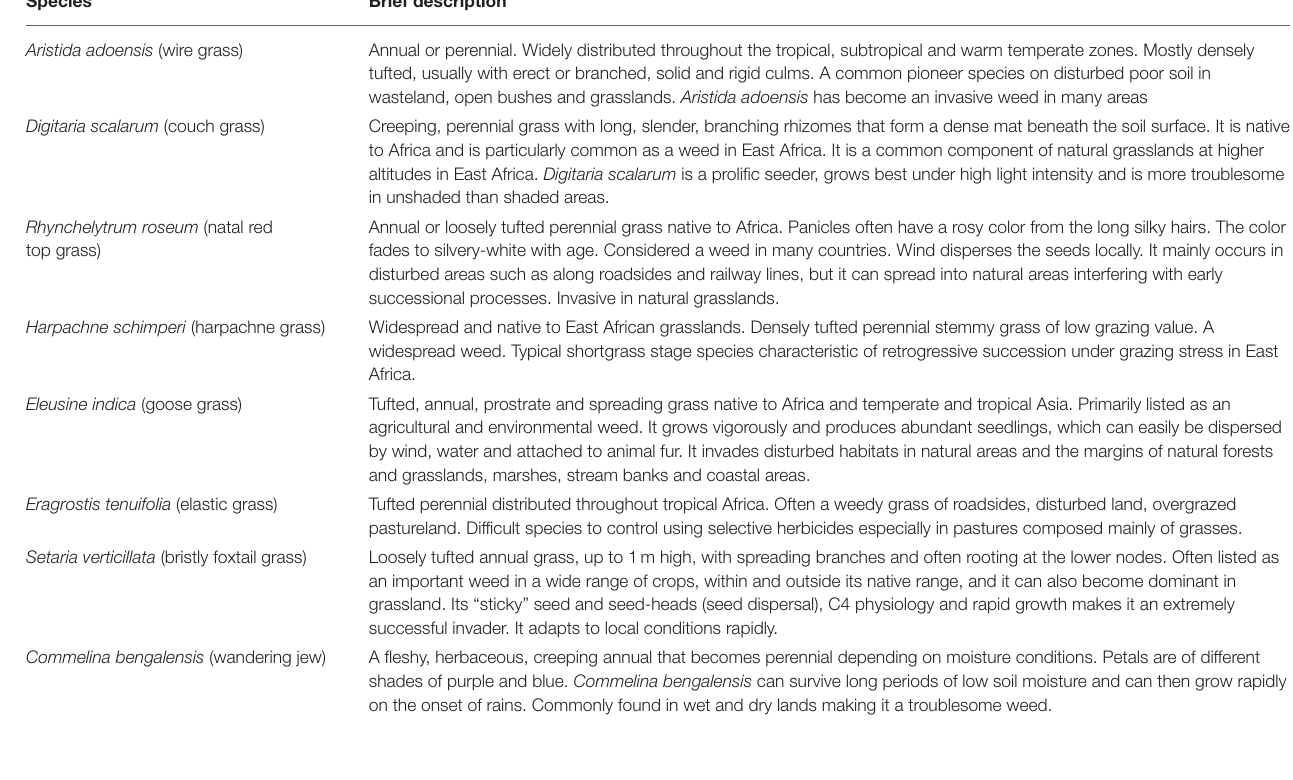
TABLE 2 | Brief description of some of weed species occurring in the reseeded areas as described in literature. Species